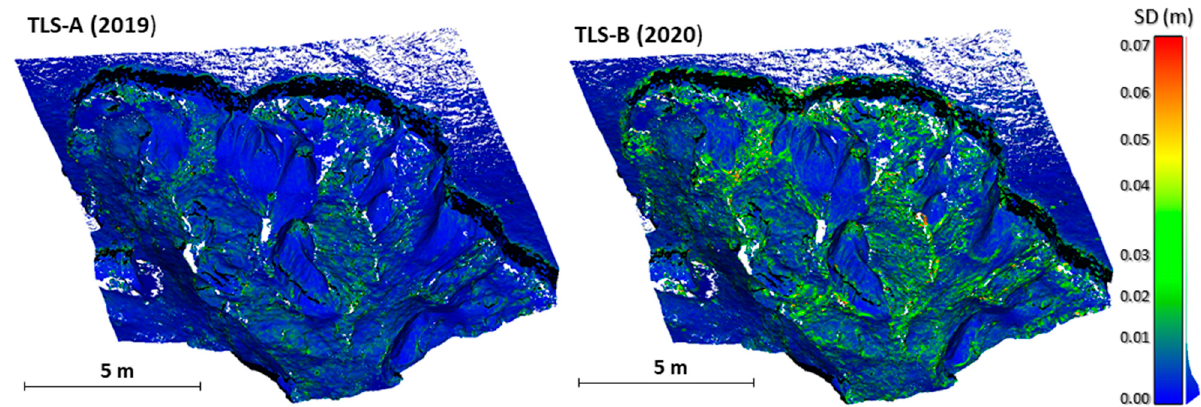
Figure 11. Comparison between the standard deviation of two multi-temporal point clouds (initial TLS survey ( left ) and final TLS survey ( right